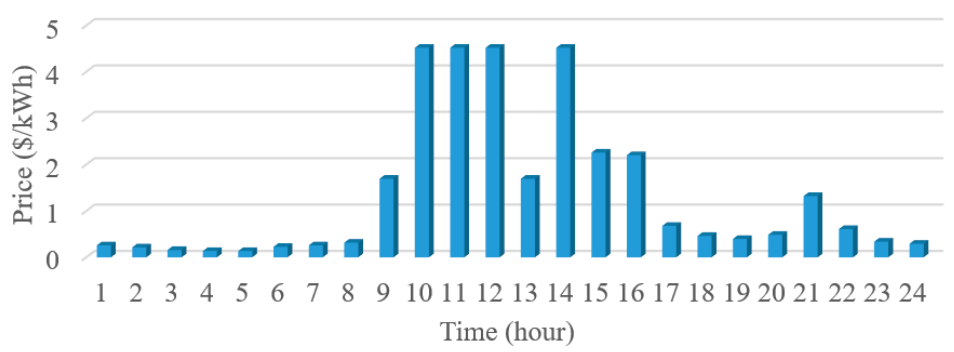
Figure 8. Hourly market price for the microgrid.